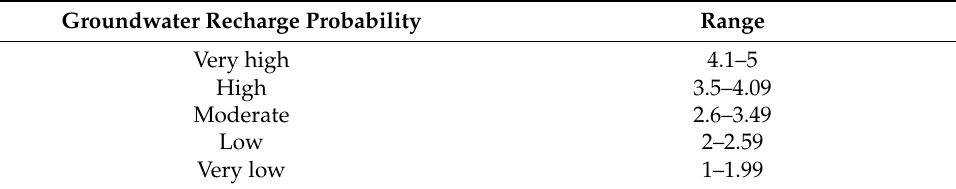
Table 1. Potential for groundwater recharge according to the numerical results of the proposed